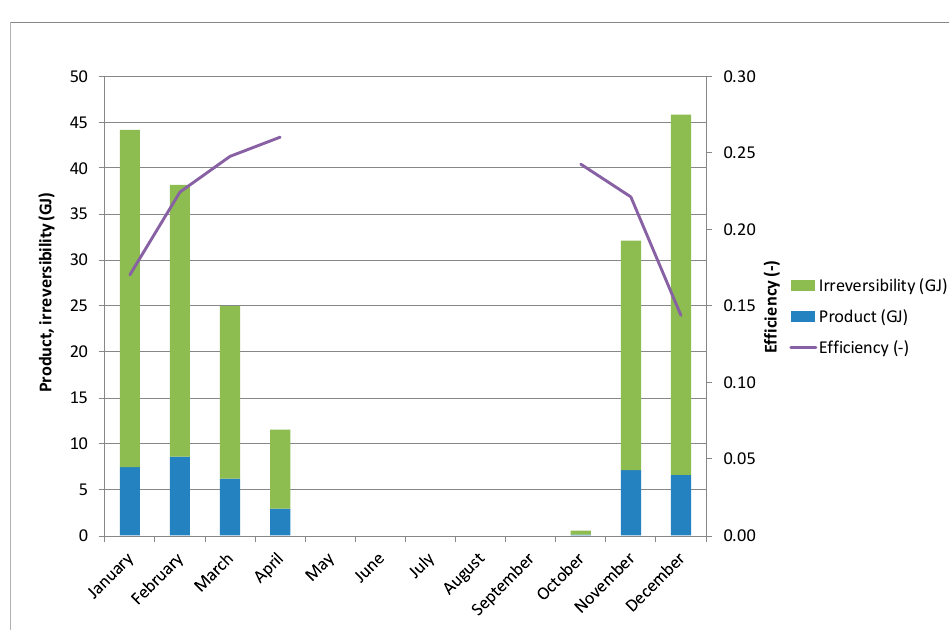
Figure 11. Heat pump: Fuel.